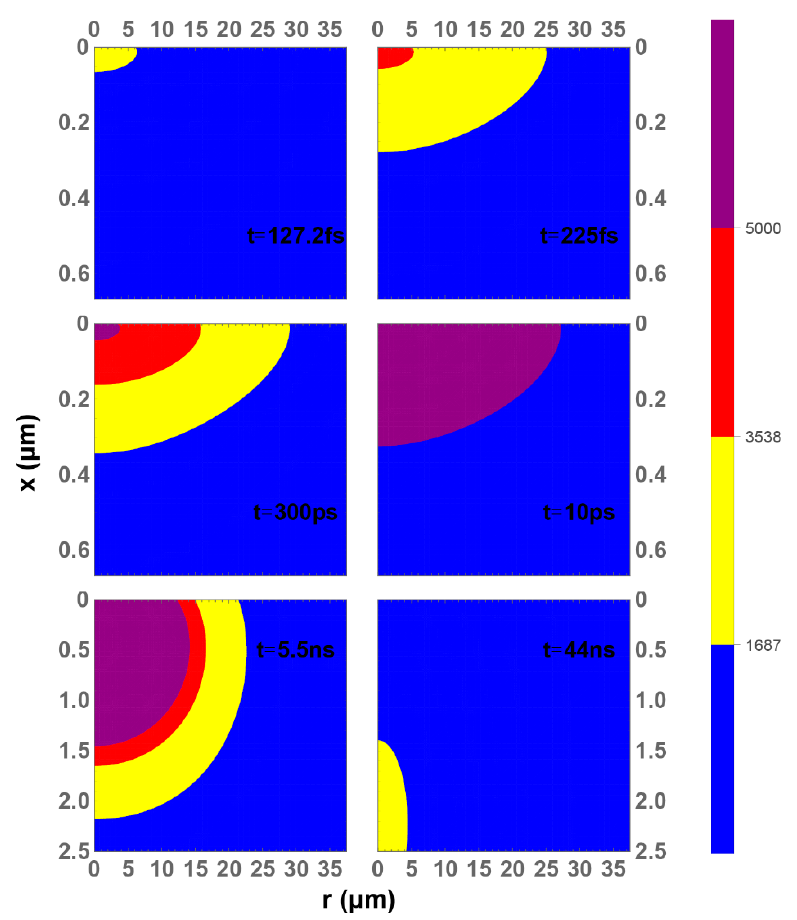
Figure 6. Mapped temperatures of silicon lattice with water cooling at selected time steps.